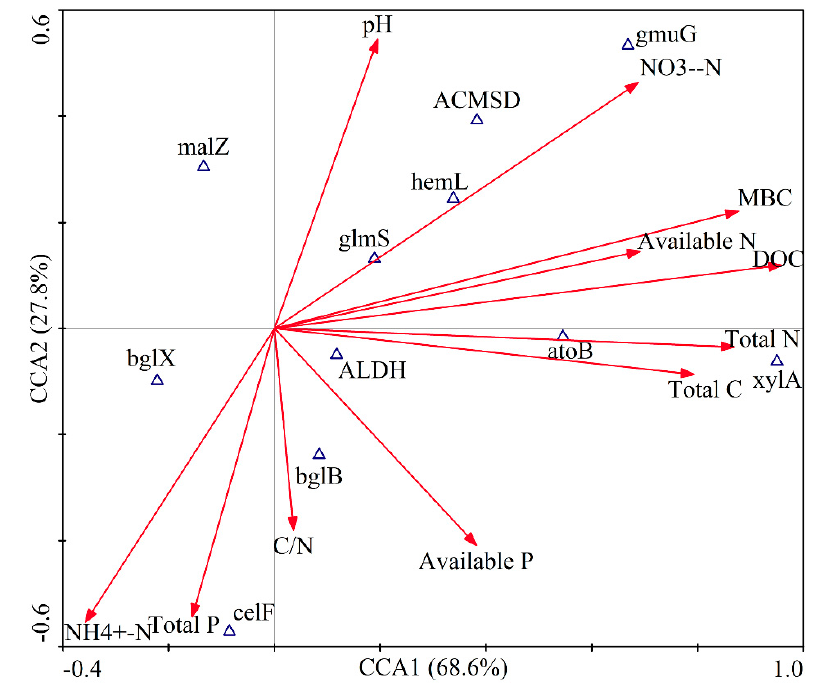
Figure 11. Canonical correspondence analysis (CCA) revealing the effects of soil characteristics on genes related to carbon cycling.